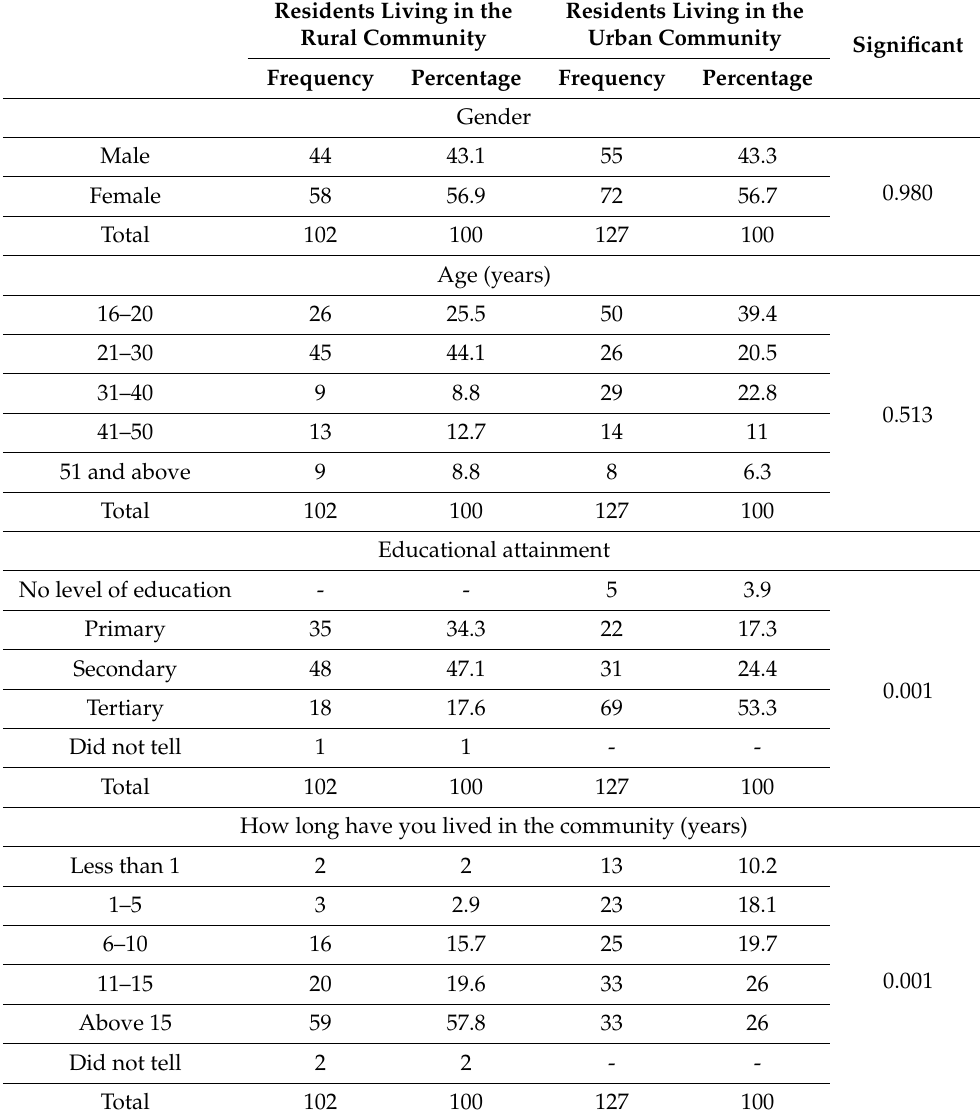
Table 2. Demographic characteristics of the participants.